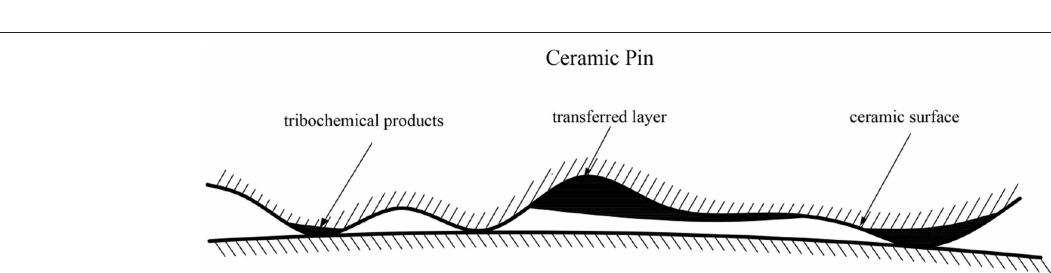
FIGURE 9 | Schematic diagram of contact model of Si 3 N 4 /titanium alloy pairs.